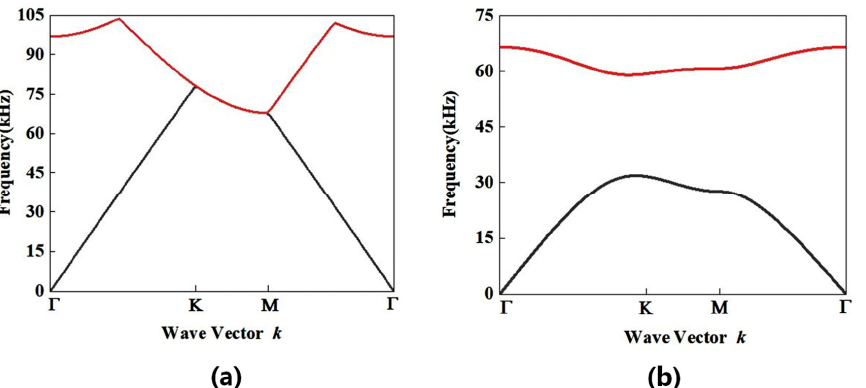
Figure 2. ( a ) Dispersion relation diagram for R 1 = R 2 = 2 mm ( b ) Dispersion relation diagram for R 1 = 3 mm, R 2 = 0.8